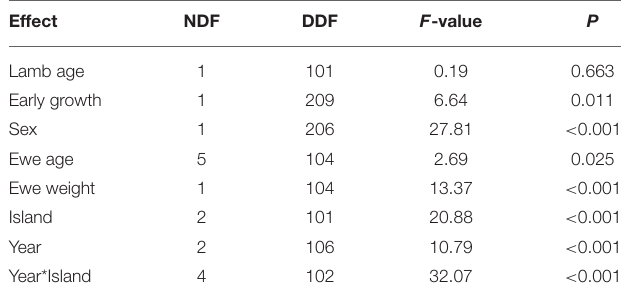
TABLE 4 | Effect of lamb age (d) at release, lambs average daily gain (g d − 1 ) from birth to release, lamb sex (male or female), age of ewe (year), ewe weight (kg) at release, islands (Sandvær, Sjonøya, Buøya), year (2012, 2013, 2014), and the interaction between year and island, their nominator Degrees of Freedom (NDF), denominator Degrees of Freedom (DDF), F and P -values.